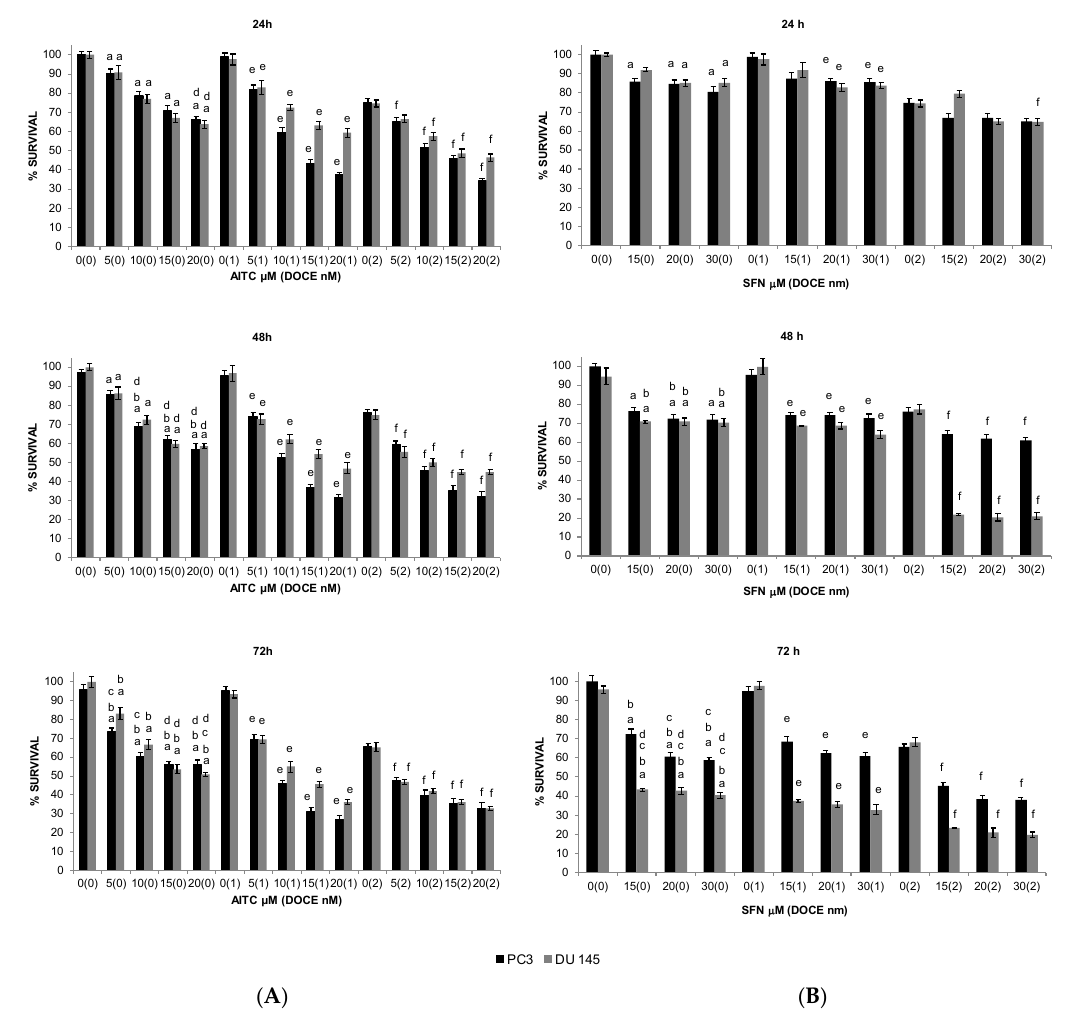
Figure 1. Time-course and dose-response of allyl-isothiocyanate ( A ) and sulforaphane ( B ) treatment e ff ects on proliferation of PC-3 (black pillar) and DU 145 (grey pillar) cells as determined by trypan blue dye exclusion assay. Prostate cancer cells were plated, allowed to attach overnight, and treated with dimethyl sulfoxide (DMSO) (control) or desired concentration of allyl-isothiocyanate (AITC) or sulforaphane (SFN) and / or DOCE (docetaxel) for specified time intervals. Both floating and adherent cells were collected and used for counting of dead and live cells. Data are shown as the mean ± SD of three independent experiments. a , p < 0.05, ITC treatment alone significantly di ff erent compared with control treatment; b , p < 0.05, ITC treatment alone for 48 or 72 h significantly di ff erent compared with ITC treatment alone for 24 h; c , p < 0.05, ITC treatment alone for 72 h significantly di ff erent compared with ITC treatment alone for 48 h; d , p < 0.05, ITC treatment alone significantly di ff erent compared with 2 nM DOCE alone; e , p < 0.05, combination treatment (ITC + DOCE 1 nM) significantly di ff erent compared with 1 nM DOCE alone; f , p < 0.05, combination treatment (ITC + DOCE 2 nM) significantly di ff erent compared with 2 nM DOCE alone (one-way